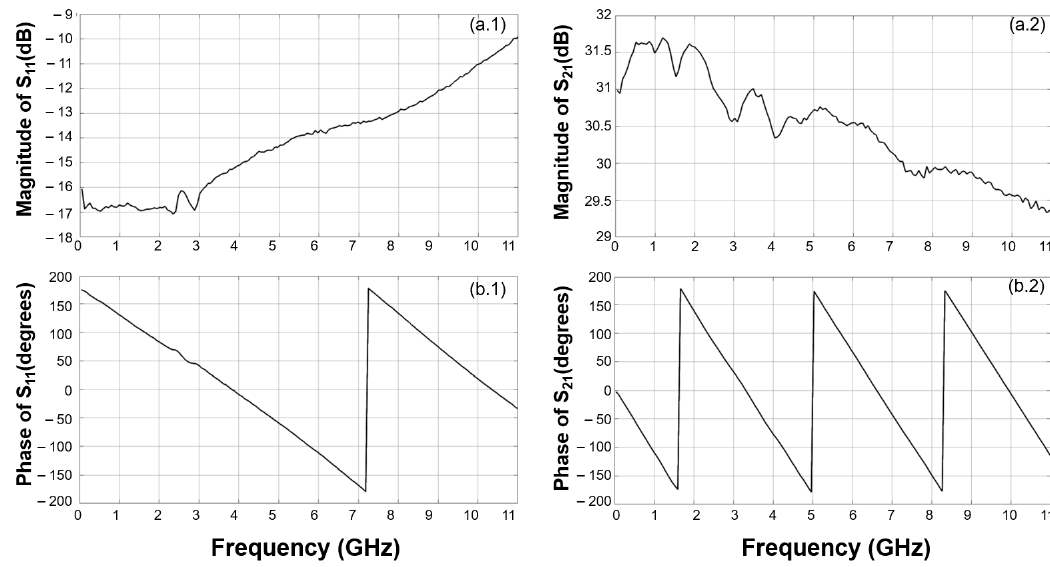
Figure 7. Magnitude and phase of S 11 and S 21 parameters of the 12 GHz amplifier with 30 dB of gain used in the experimental setup: ( a.1 ) S 11 magnitude, ( a.2 ) S 21 magnitude, ( b.1 ) S 11 phase and ( b.2 ) S 21 phase.